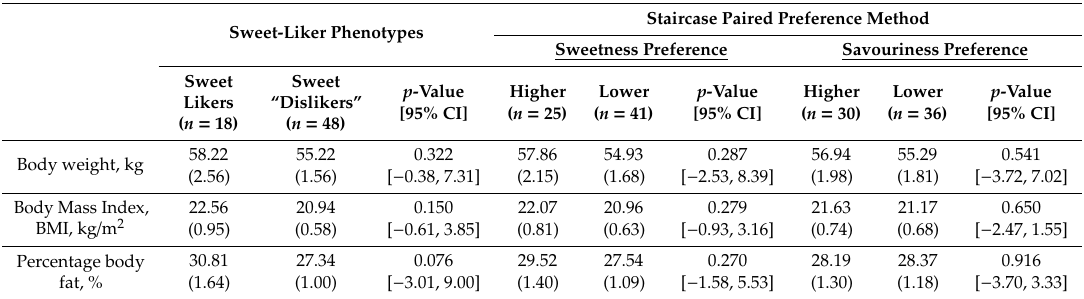
Table 4. Associations between sweet-liker phenotypes, sweetness and savouriness preferences and body composition profiles ( n = 66) 1